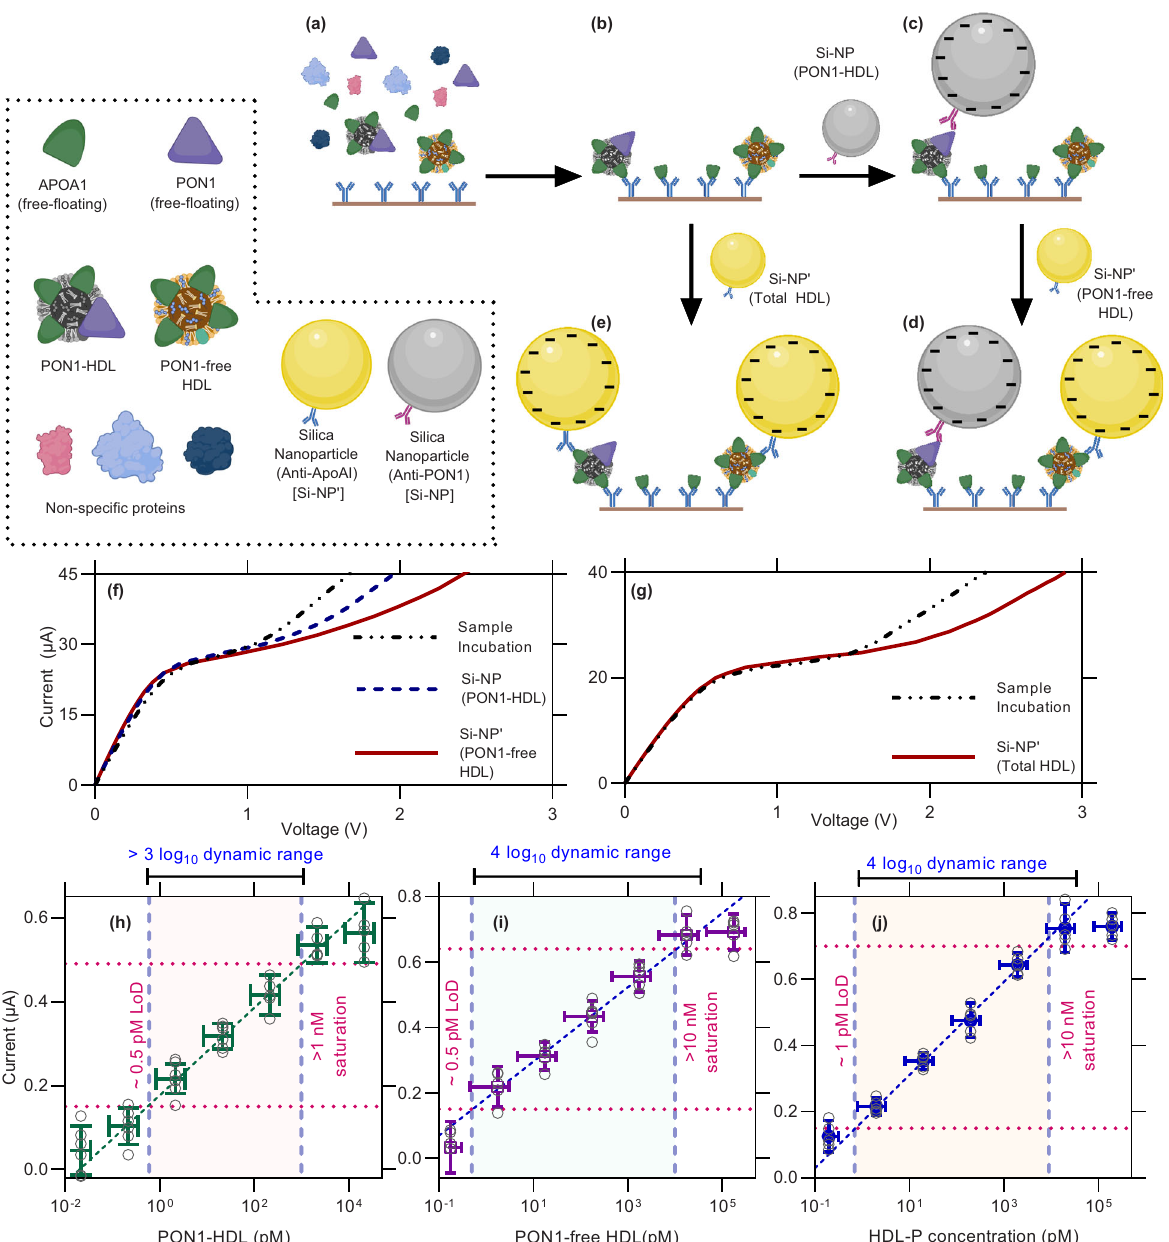
Fig. 2 | Calibration of voltage shifts to target concentration. a – e Schematic showing the assaysteps of the NGEMS platform. The washing stepwith 4×PBS and 0.1×PBS buffer is employed after each sample and nanoparticle incubation step before an CVC is recorded. a Sample is incubated for 20min on the anti-ApoAI functionalizedAEMsurfaceandthenthewashstepsemployed. b CapturedHDLon the AEM surface that gives a CVC used as the baseline signal. c Addition of silica particles functionalized with anti-PON1 (Si-NP) gives a voltage shift depending on number of captured PON1-HDL. d Addition of silica particles with anti-ApoAI (Si-NP')bindstounoccupiedHDLin c givingashiftproportionaltoPON1-freeHDL. e Direct addition of silica reporters with anti-ApoAI (Si-NP') binds to all the HDL